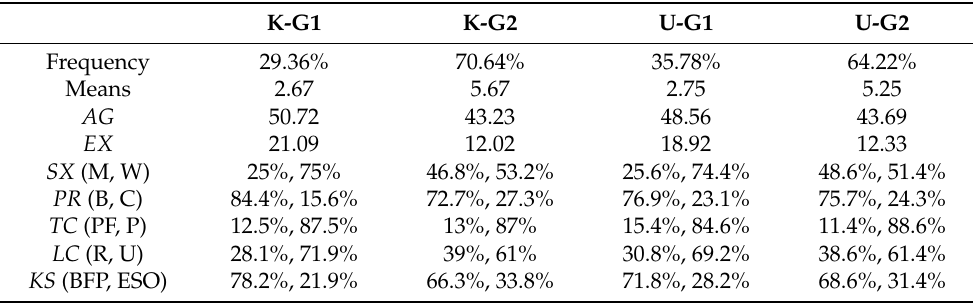
Table 14. Cluster groups as regards the knowledge and use of problem solving tools